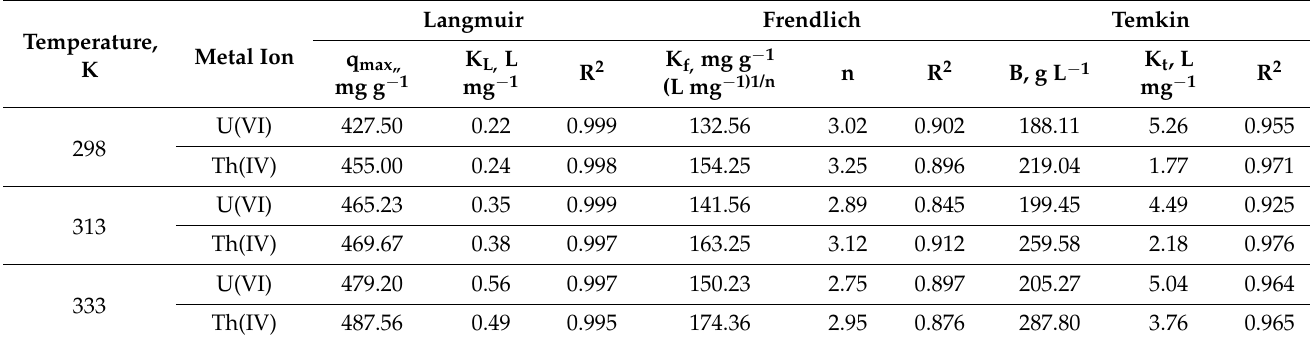
Table 2. Parameters of the Langmuir and Freundlich isotherms for U (VI) and Th(IV) removal by PGO–Gd.